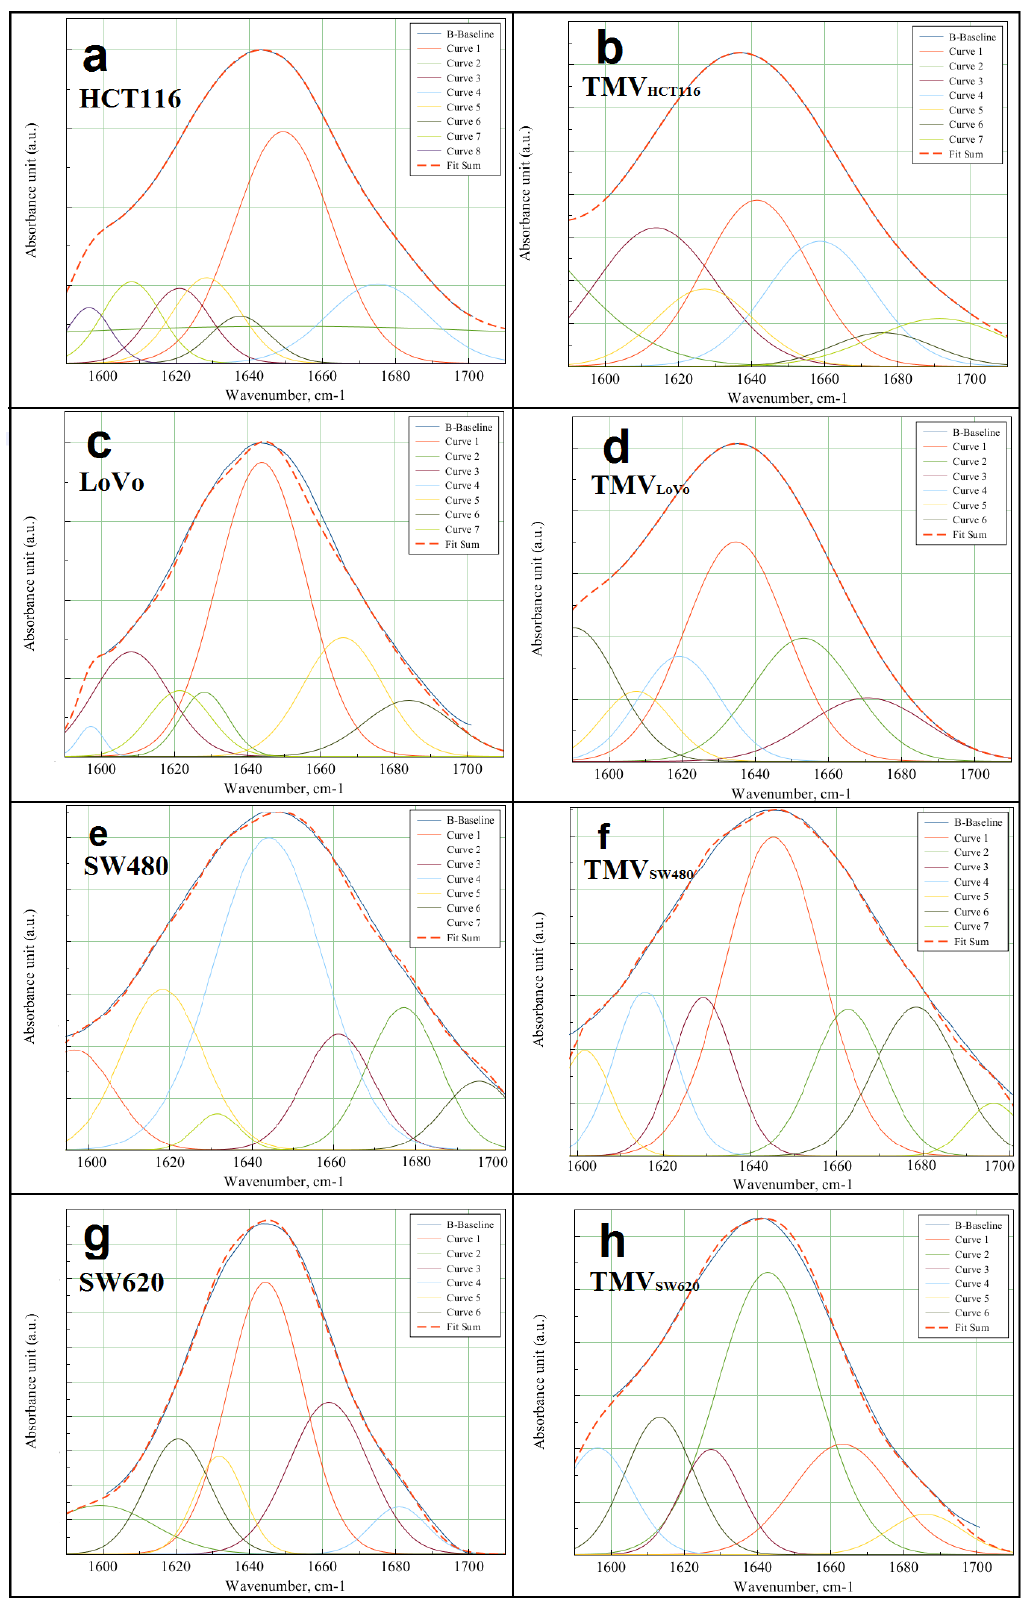
Figure 6. Deconvolution of amide I FTIR region (1700–600 cm −1 ) obtained for cell lines: ( a ) HCT116; ( b ) TMV HCT116 ; ( c ) LoVo; ( d ) TMV LoVo ; ( e ) SW480; ( f ) TMV SW480 ; ( g ) SW620 and ( h ) TMV SW620 . Curves 1–8 show the matched Gaussian functions and fit sum-results obtained by the matched Gaussian functions.